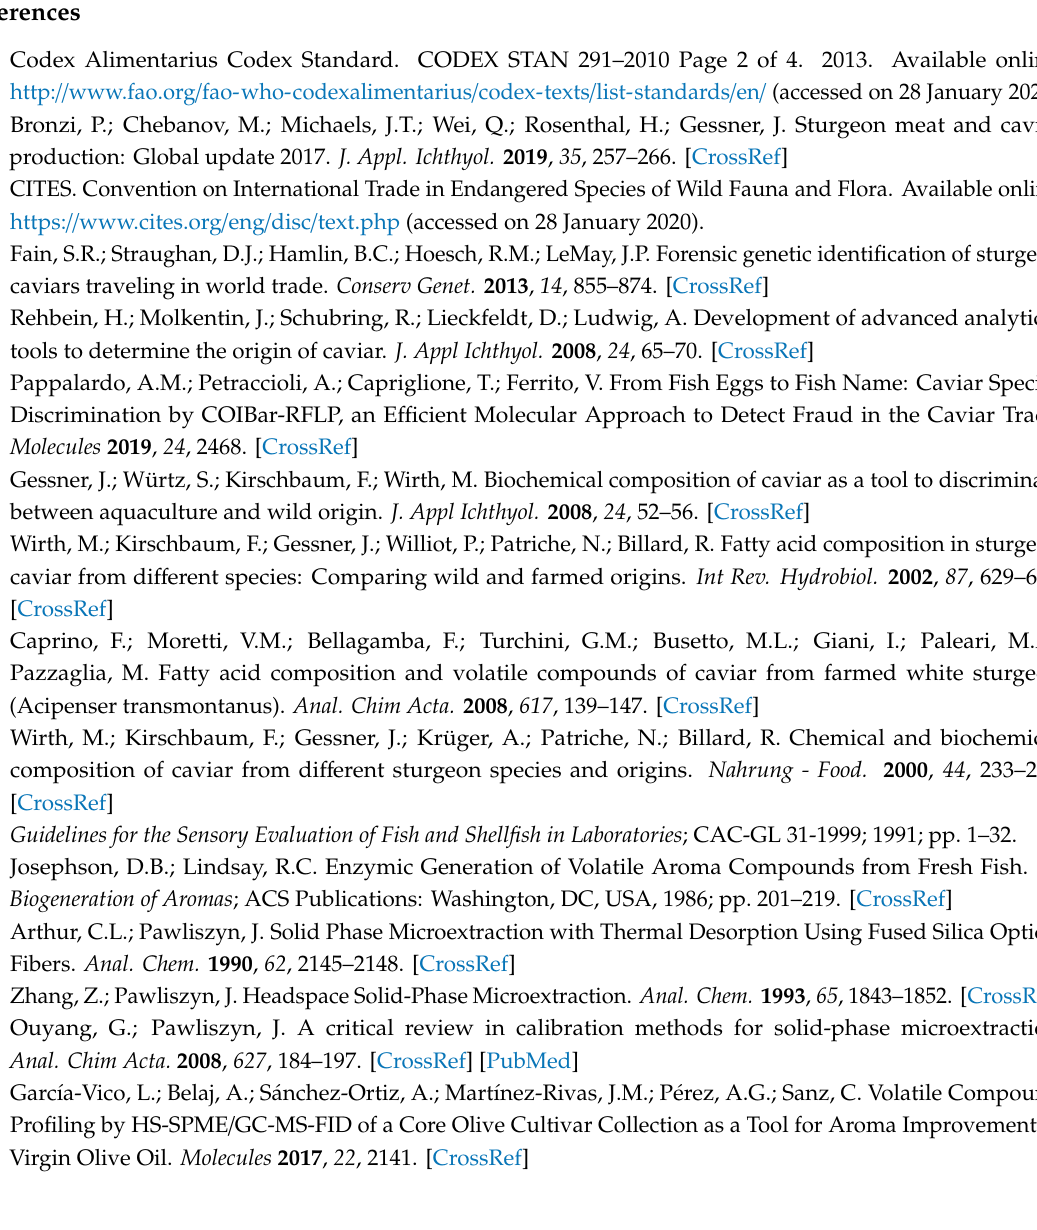
Figure S1. Illustrative multiple headspace solid phase microextraction protocol on a calibration mixture using an automated MPS multipurpose sampler (Gerstel Mullheim a / d Ruhr,